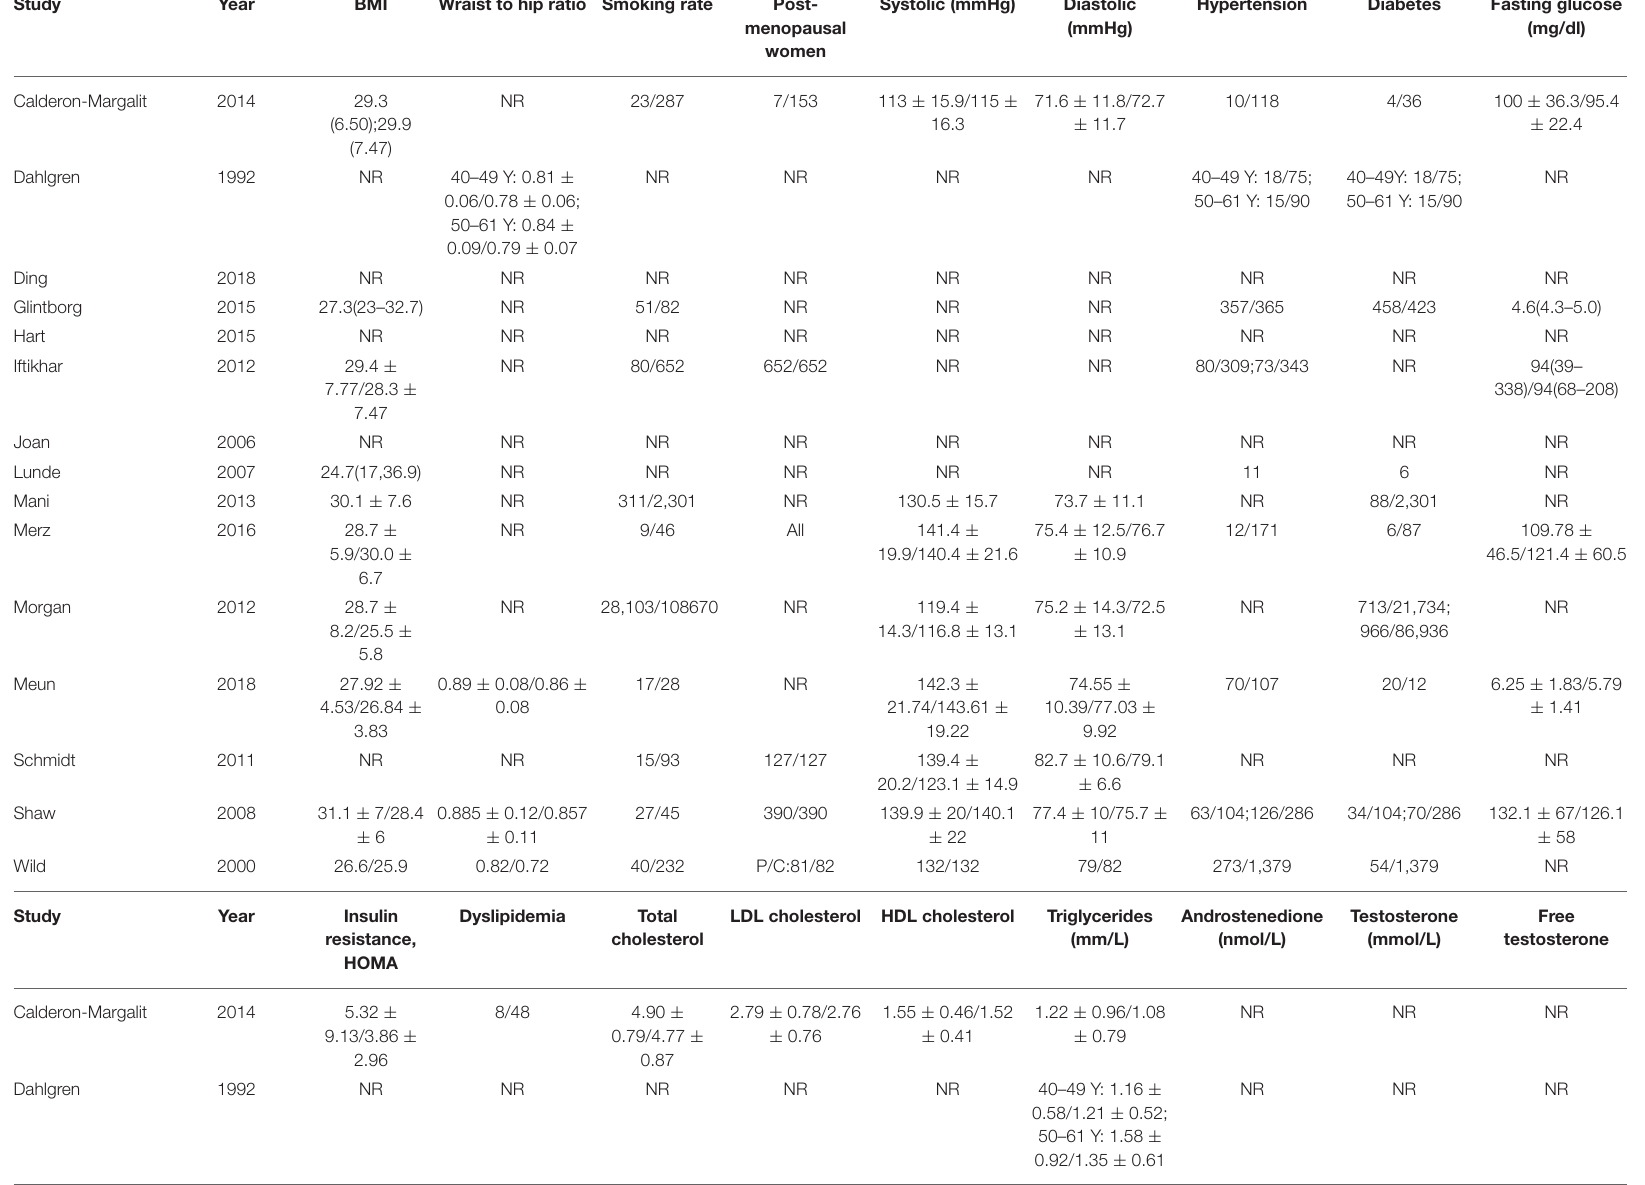
TABLE 2 | Clinical physiological and biochemical characteristics of individual studies.